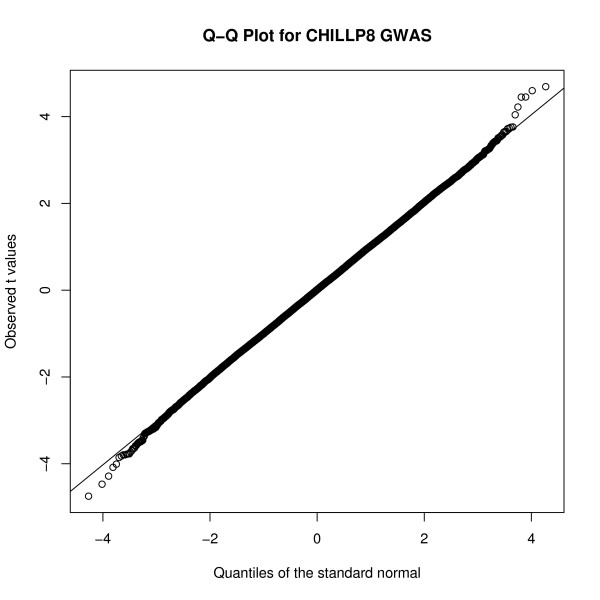
The Q-Q plot of t-values in the CHILLP8 GWAS. The quantile-quantile plot of the observed distribution of the t-values for the GWAS of CHILLP8 compared to the theoretical distribution. The plot represents at least 50 thousand data points. Points at the extreme of the observed distribution show values that were larger than expected.